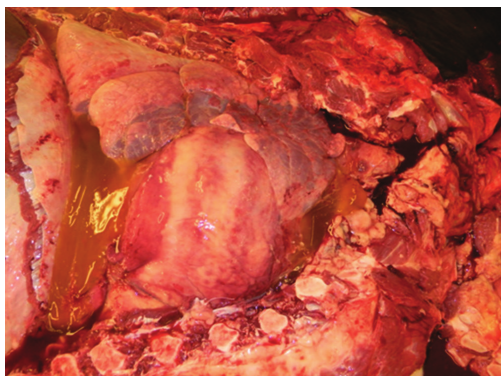
Figure 4: Ultrasonogram of pericardial e ff usion with strands of fibrin on the epicardium obtained by 3.5 MHz convex transducer placed in the fifth intercostal space on the left thorax. 1: thoracic wall; 2: parietal pleura; 3: pleural e ff usion; 4: lung 5: hypoechogenic pericardial e ff usion; 6, thickened pericardium with fibrin strands; 7, atrial wall.